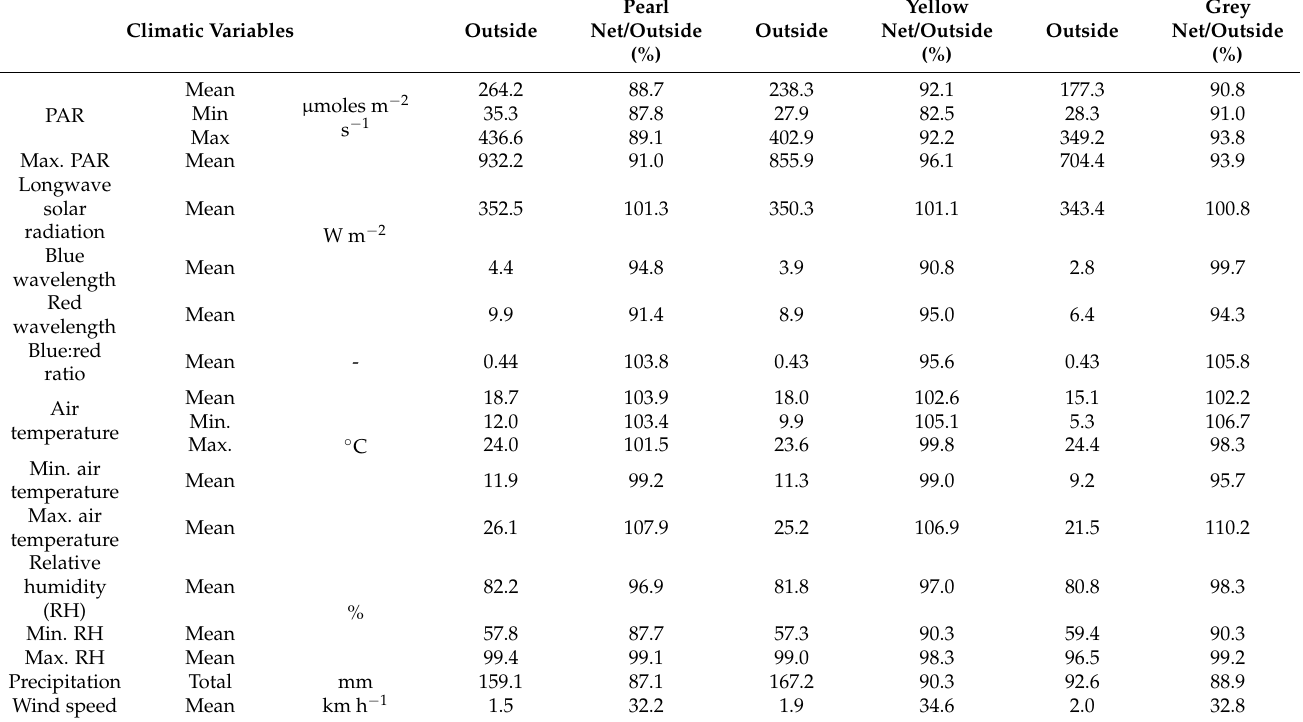
Table 2. Mean, minimum and maximum values of climatic variables outside and the ratio [under the photo-selective nets/outside conditions] (%) for the pearl, yellow and grey nets during different observation periods from July to November